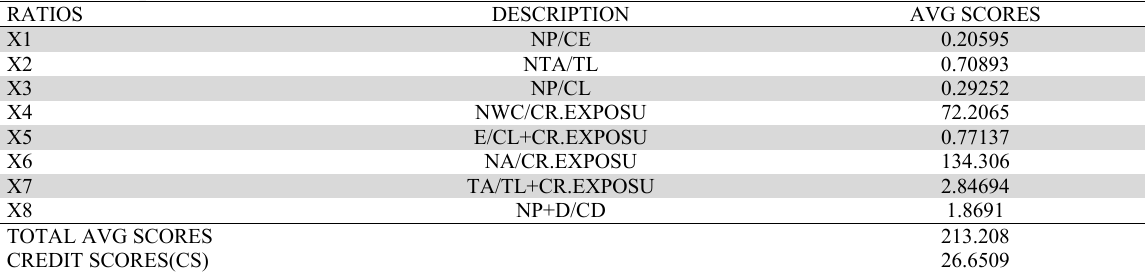
Risk Description Model – Ratio